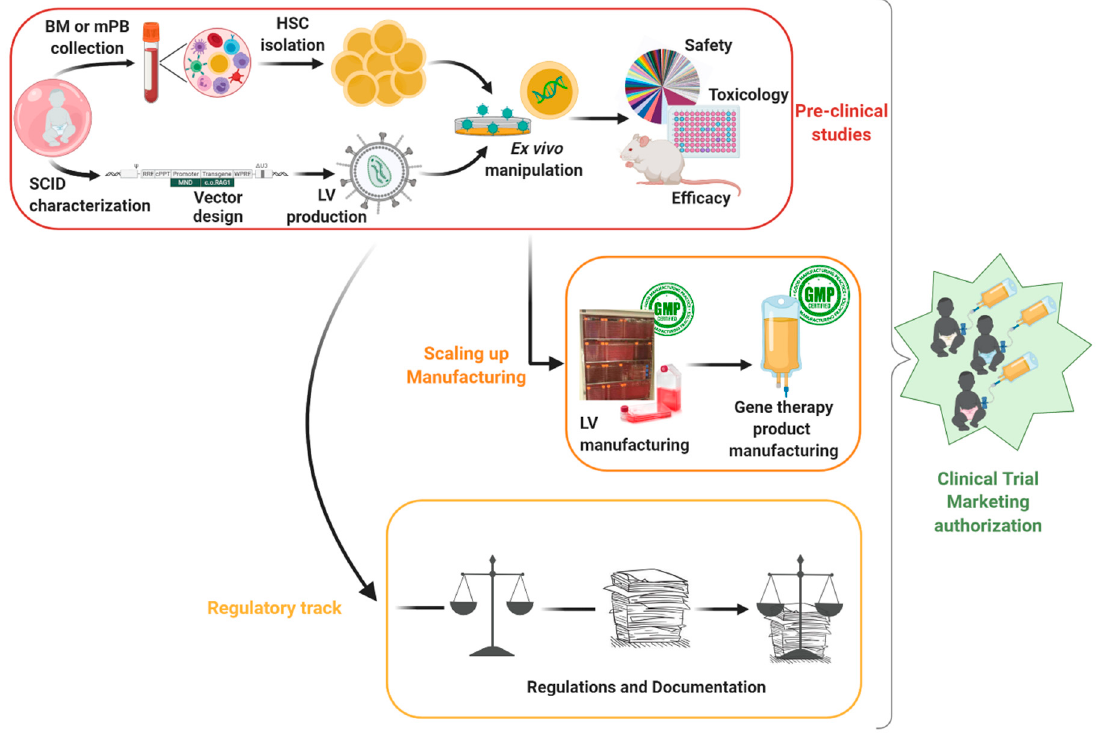
Figure 1. Overview of the pre-clinical assessments of gene therapy treatment: From disease modeling to clinical application (Bone Marrow (BM); mobilized Peripheral Blood (mPB); Hematopoietic Stem Cell (HSC); Lentiviral Vector (LV); Severe Combined Immunodeficiency (SCID)).